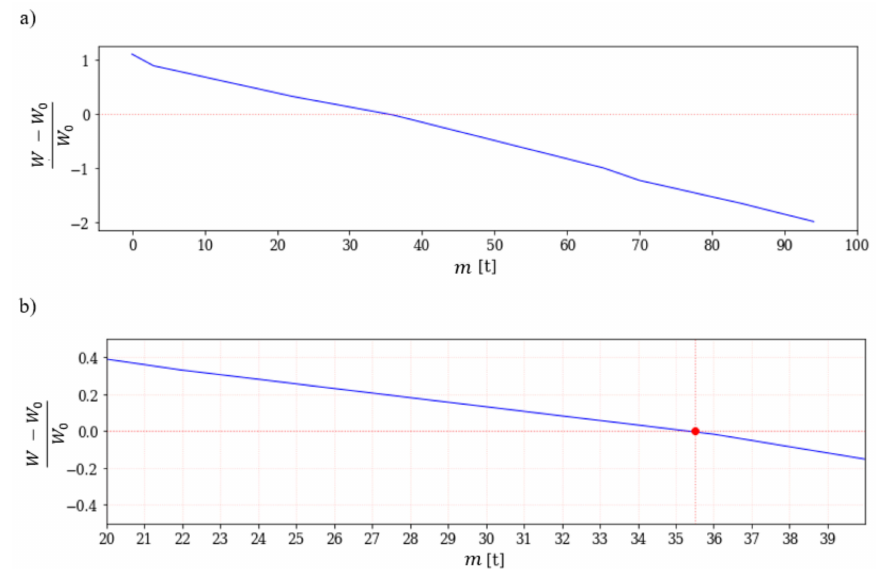
Figure 6. ( a ) Graph of the final energy dependence on the amount of fuel saved in the side thrusters tanks; ( b ) The same graph in the range between 20 and 40 tons with an indication how much fuel the model flight could save. The red dot represents the point where the final energies of the rocket in real and model flights are the